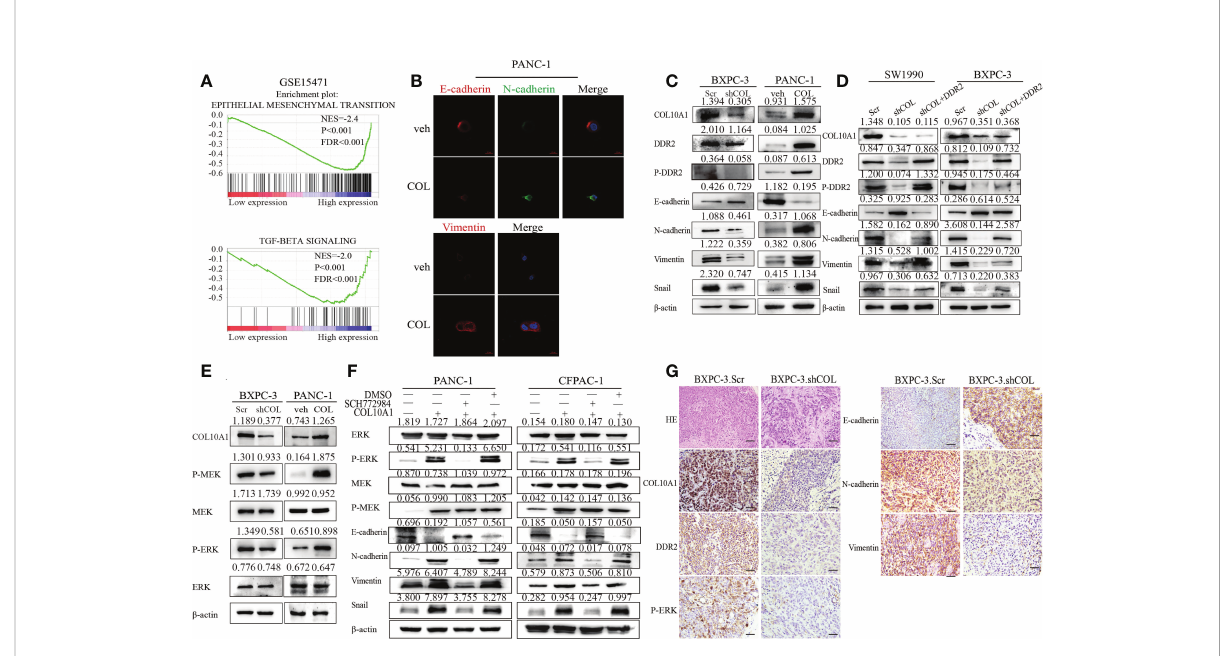
FIGURE 6 COL10A1-DDR2 axis promotes EMT in PDAC cells through activation of MEK/ERK pathway. (A) GSEA validated EMT-related pathways in high COL10A1 expression PDAC cohorts of GSE15471 dataset. (B) The effect of COL10A1 on the expressions of EMT signaling proteins by Immuno fl uorescence. (C) The effect of COL10A1 and DDR2 on the expressions of EMT signaling proteins by Western blot. (D) Western blot detection of the effect of overexpression of DDR2 on protein expression changes in the EMT pathway induced by interference with COL10A1. (E) Western blot analyses of MEK/ERK pathway proteins in the indicated cells. (F) The protein expression of EMT pathway was detected by western blot in PDAC cells after treated with ERK inhibitor SCH772984. (G) H&E staining and IHC staining of COL10A1, DDR2, P-ERK, E-